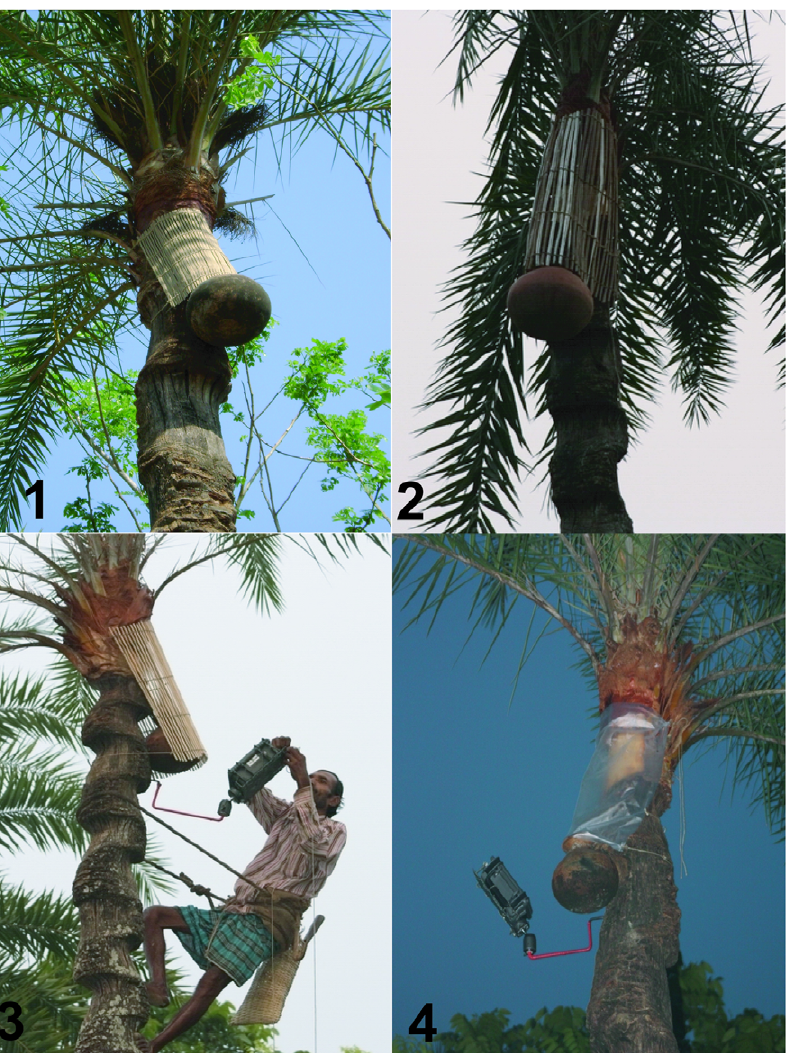
Figure 2. Interventions to prevent bat drinking date palm sap during session two: 1. Bamboo skirt; 2. Dhoincha skirt; 3. Jute stick skirt; and 4. Polythene skirt covering the sap producing areas of the date palm tree. In the later pictures, we can see sap harvester setting up an infrared camera.